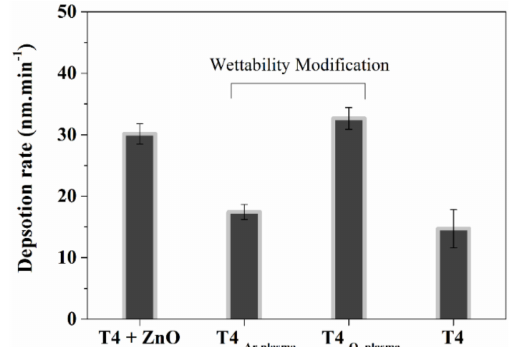
Figure 2. Deposition rate of T4 on silicon wafer substrate during wettability and nanoparticle